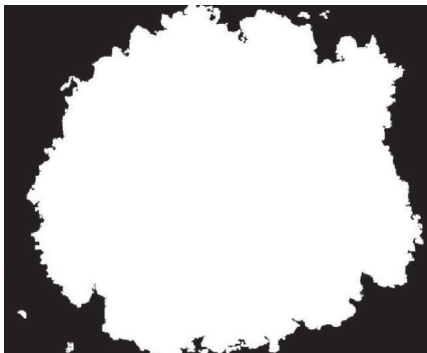
Figure 8: Image processed by intersection. The extraction of boundary is accurate, and the pseudo-edge removal is